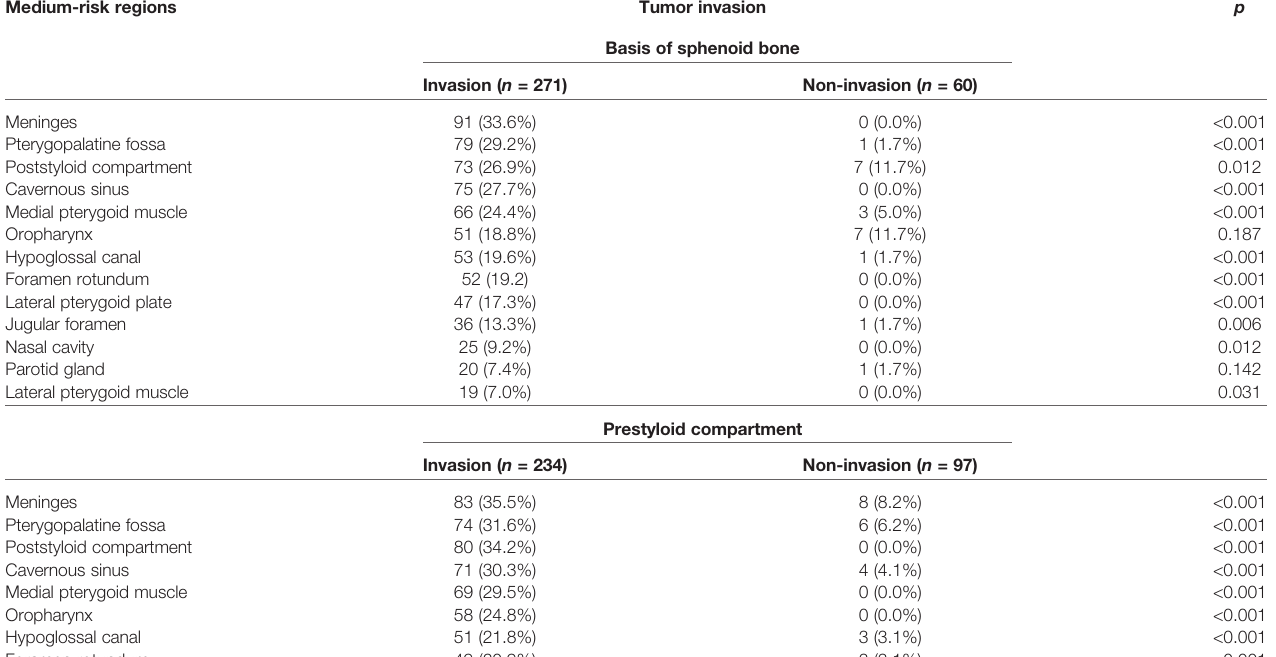
TABLE 3 | Relationship between primary tumor invasion into the high-risk regions and the medium risk